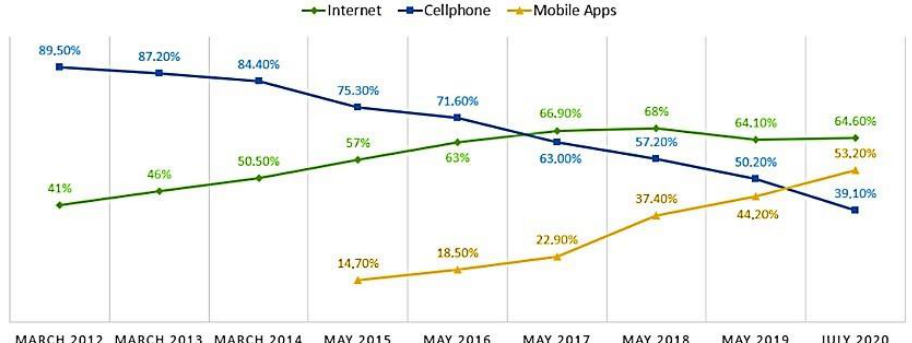
Figure 2. Dynamics of the popularity of the word “delivery” (“dostavka” in Russian) in Google search queries in Russia over the past 5 years.